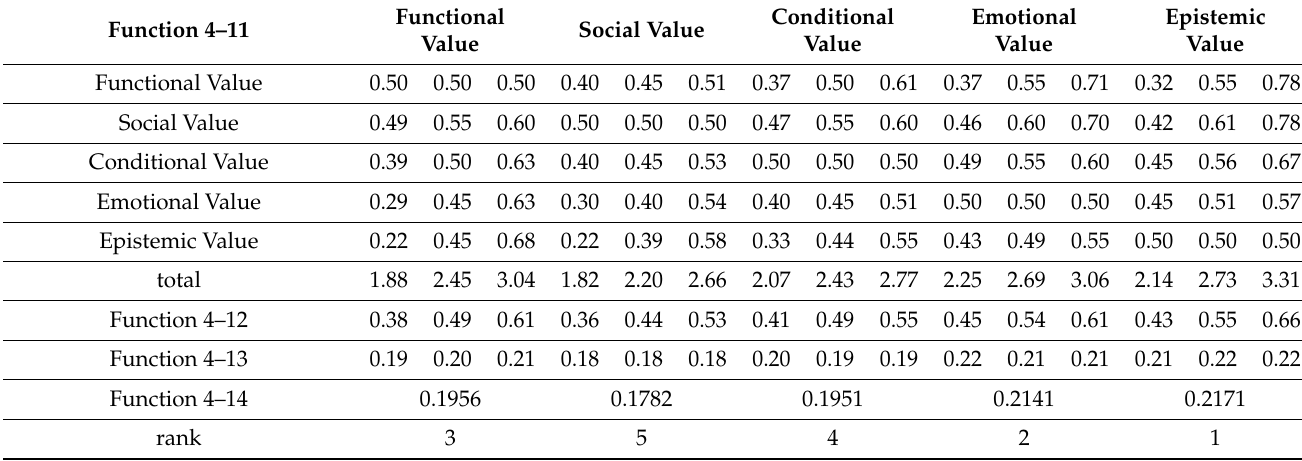
Table A8. Travel agencies’ weights of aspects of the service quality.